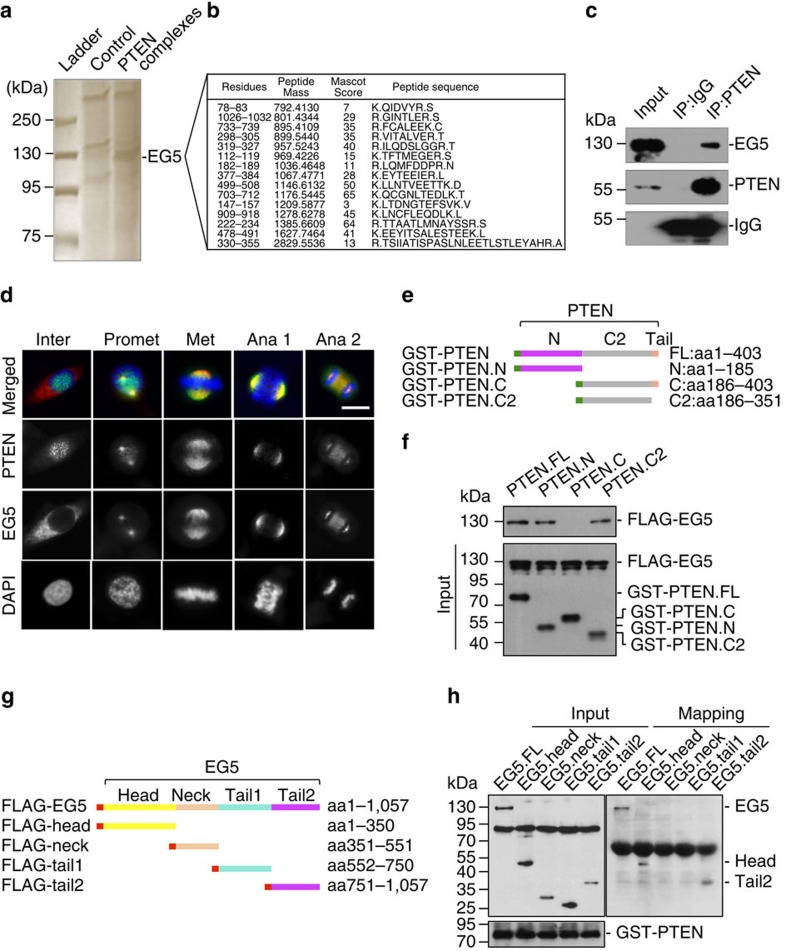
PTEN colocalizes and interacts with EG5 during mitosis.(a) Identification of EG5 as a component of PTEN-associated protein complexes by pull-down assay. HeLa cells containing FLAG-HA-tagged PTEN or a control vector were synchronized by releasing from double thymidine block for 8 h before tandem affinity purification and separation on SDS-PAGE gel. A 125-kD band was analysed by mass spectrometry (MS) revealing EG5 as a potential PTEN-associated protein. (b) A list of matched peptides from MS analysis. (c) Validation of the interaction between PTEN and EG5 in vivo. HeLa cell lysates were immunoprecipitated with an anti-PTEN monoclonal antibody followed by detection of EG5 by Western blotting. The same blot was probed with a polyclonal PTEN antibody. (d) Co-localization between PTEN and EG5 during mitosis. HeLa cells were fixed for immunofluorescent staining of PTEN (green in overlay images) and EG5 (red) before confocal microscopic analysis of spatial relationship between PTEN and EG5 during the cell cycle. DNA was counterstained with DAPI. Scale bar, 10 μm. (e) GST-tagged PTEN constructs for mapping the EG5-binding domains. (f) In vitro binding assay with FLAG-tagged full-length EG5 and GST-tagged different domains of PTEN as indicated. (g) FLAG-tagged full-length EG5 and different fragments were constructed for mapping the PTEN-binding region. (h) EG5 and its fragments with a FLAG tag as indicated in g were expressed in HEK293T cells (left panel) for in vitro interaction with Sf9-expressed His-PTEN. Ni-NTA purified protein complexes were subjected to FLAG and PTEN immunoblotting (right panel).